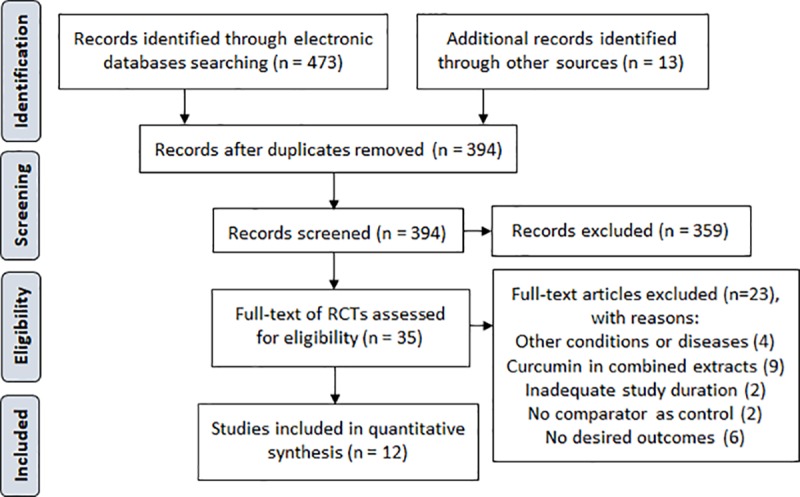
PRISMA flow diagram of the study selection.